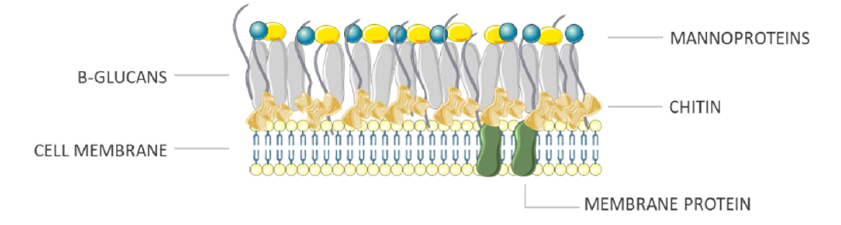
Figure 4. Fungal